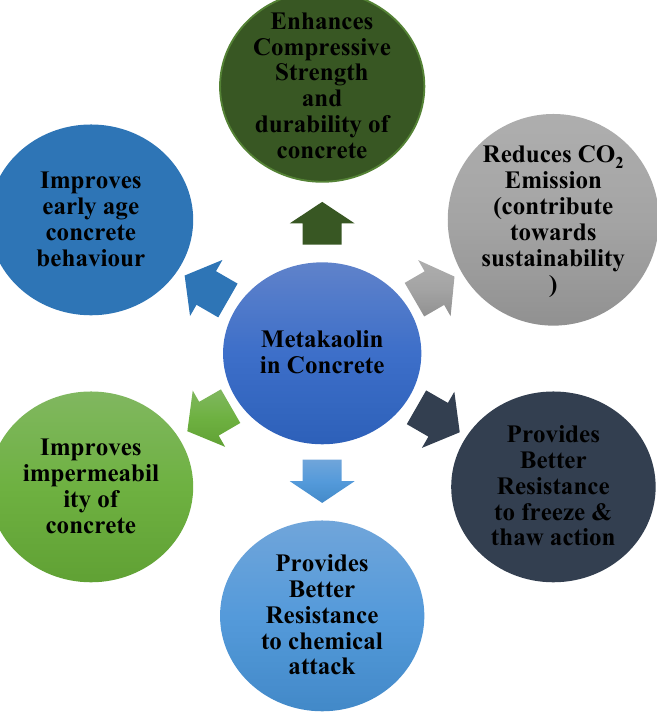
Figure 1. Advantages of metakaolin in concrete.